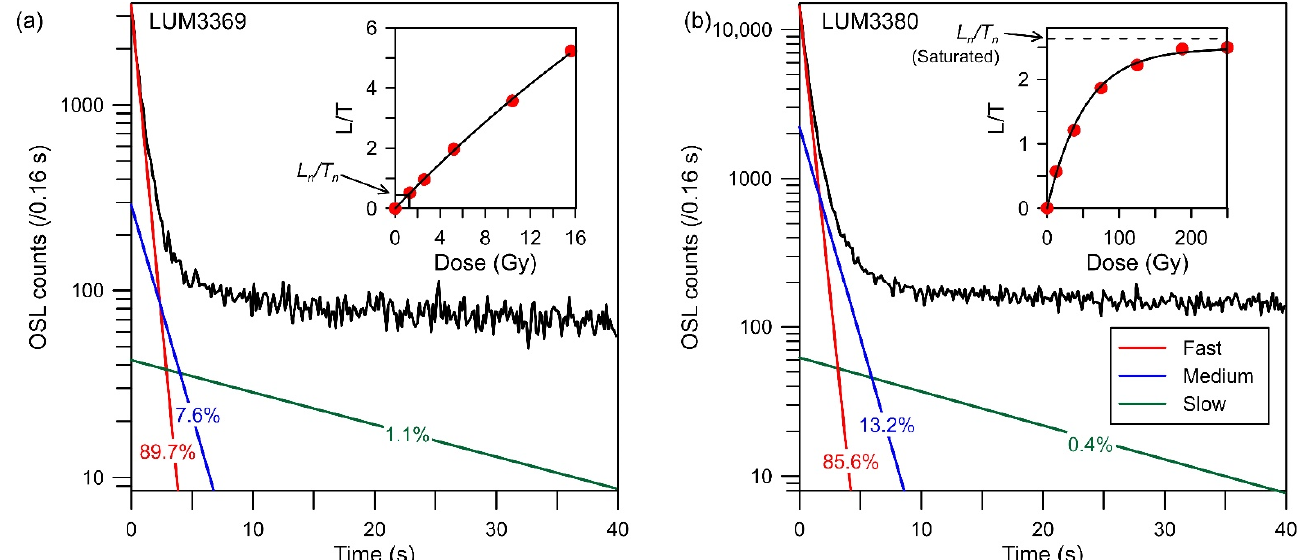
Figure 3. Shine-down curve and dose–response curve (inset) for two representative samples, LUM3369 ( a ) and LUM3380 ( b ). Results of component analysis of the quartz OSL signal are shown.